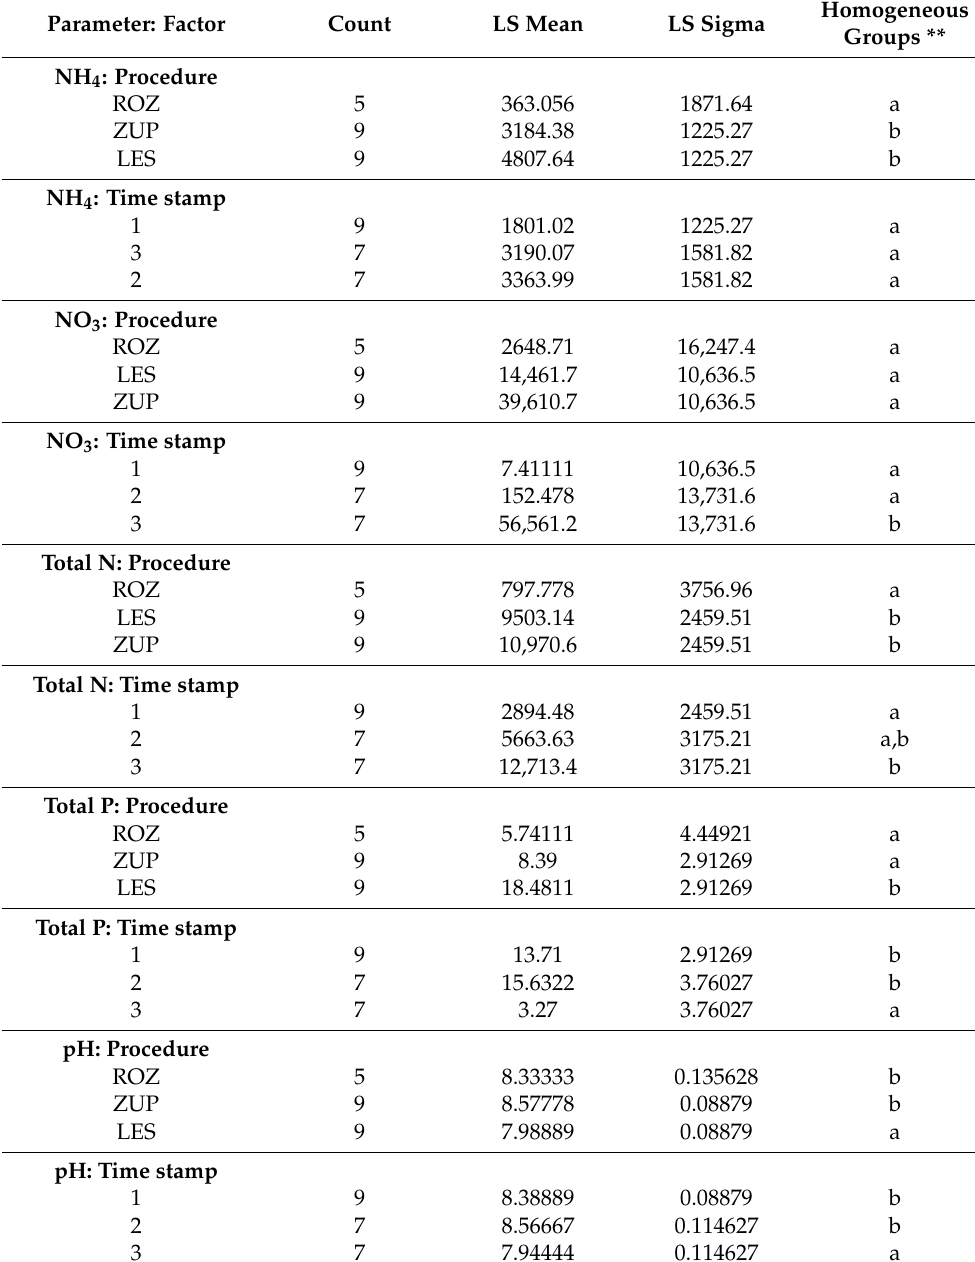
Table 3. Leachate parameters—Duncan’s multiple-range tests for two factors (nutrient quantity leached in mg/m 2 ; pH values are